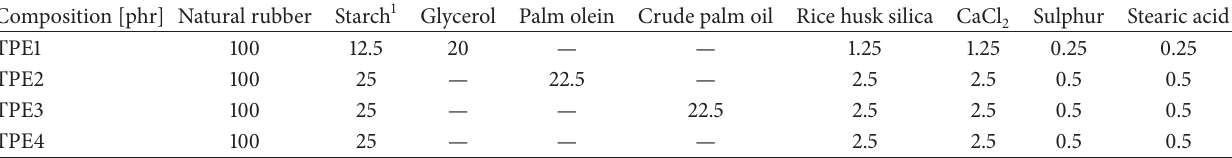
Table 1: Proportion of plasticized Tacca leontopetaloides starch/natural rubber